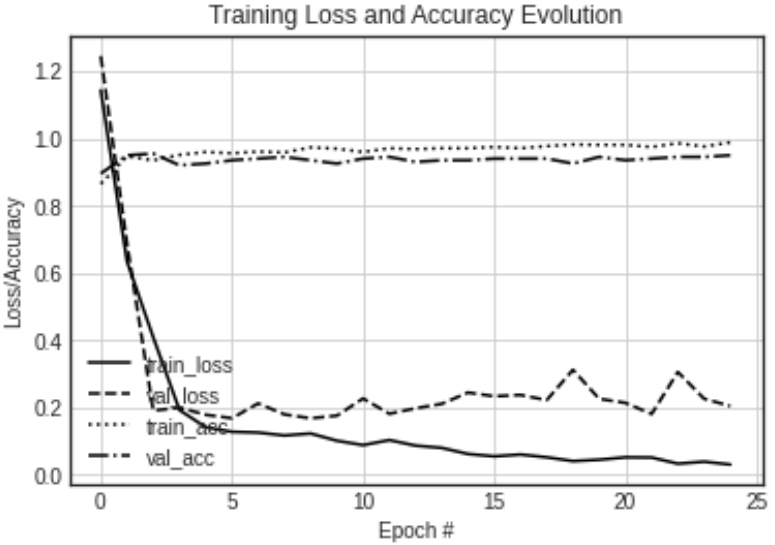
Figure 7. Evolution of the training of the Xception